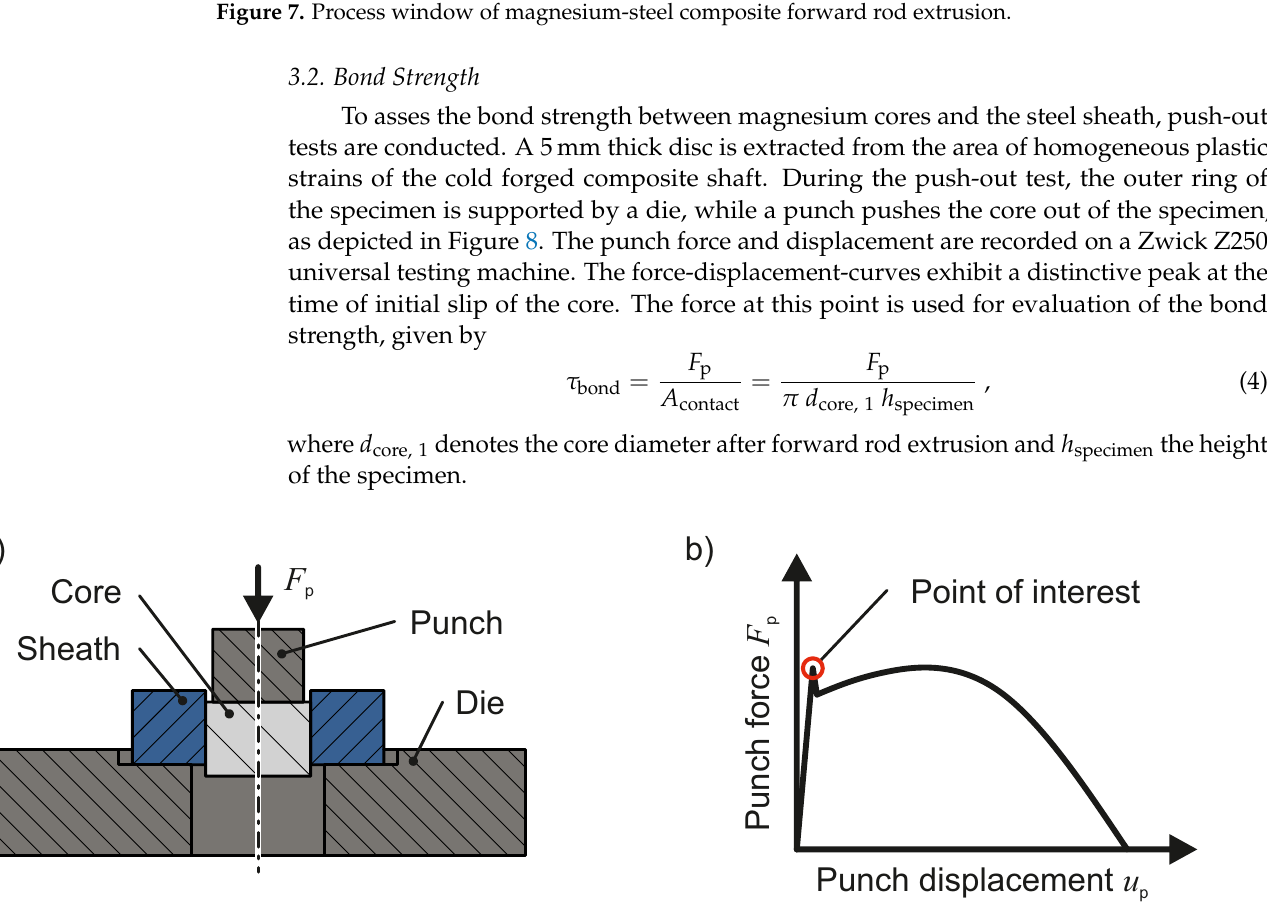
Figure 8. Principle of push-out testing: ( a ) tool set up and ( b ) evaluation of obtained